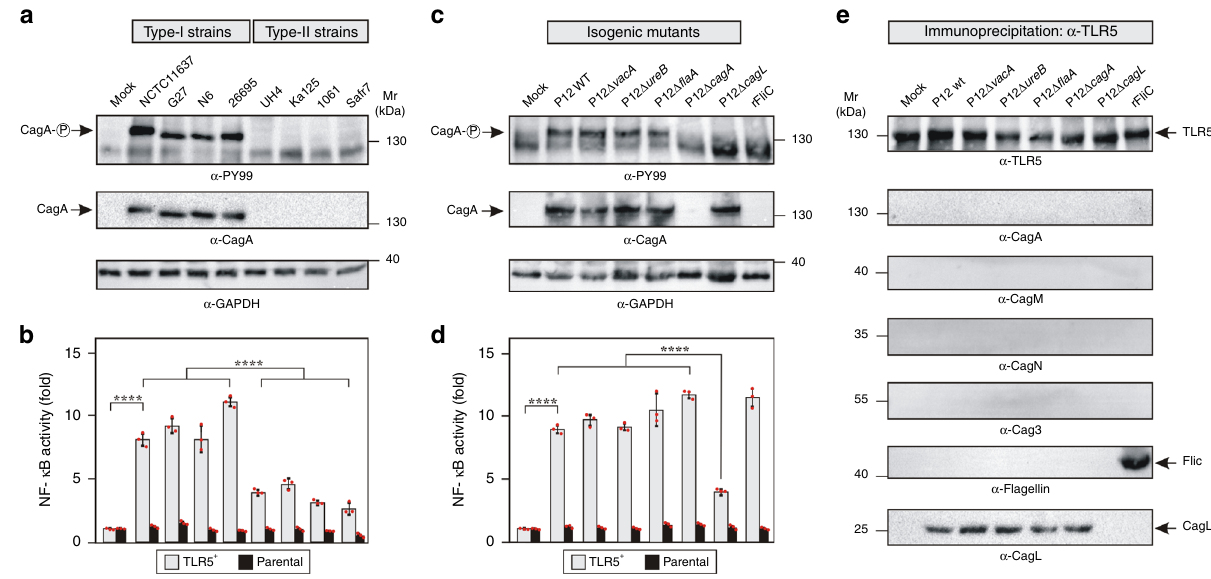
Fig. 1 Activation of TLR5 by cag PAI-positive, but not cag PAI-negative H. pylori strains. a H. pylori type-I, but not type-II strains, express a functional T4SS allowing for CagA phosphorylation in infected AGS cells as control. b TLR5 activation as quanti fi ed by NF- κ B luciferase reporter gene assay is restricted to type-I isolates in HEK reporter cells. c CagA delivery and its phosphorylation in AGS cells require functional cagL and cagA , but not vacA , ureB and fl aA genes. d TLR5 activation in HEK293 cells requires functional cagL . Recombinant fl agellin (rFliC) of Salmonella was used as positive control. e , CagL and rFliC interact with TLR5 on TLR5 + cells as determined by immunoprecipitation with α -TLR5 antibodies. Quantitative data are shown as means ±